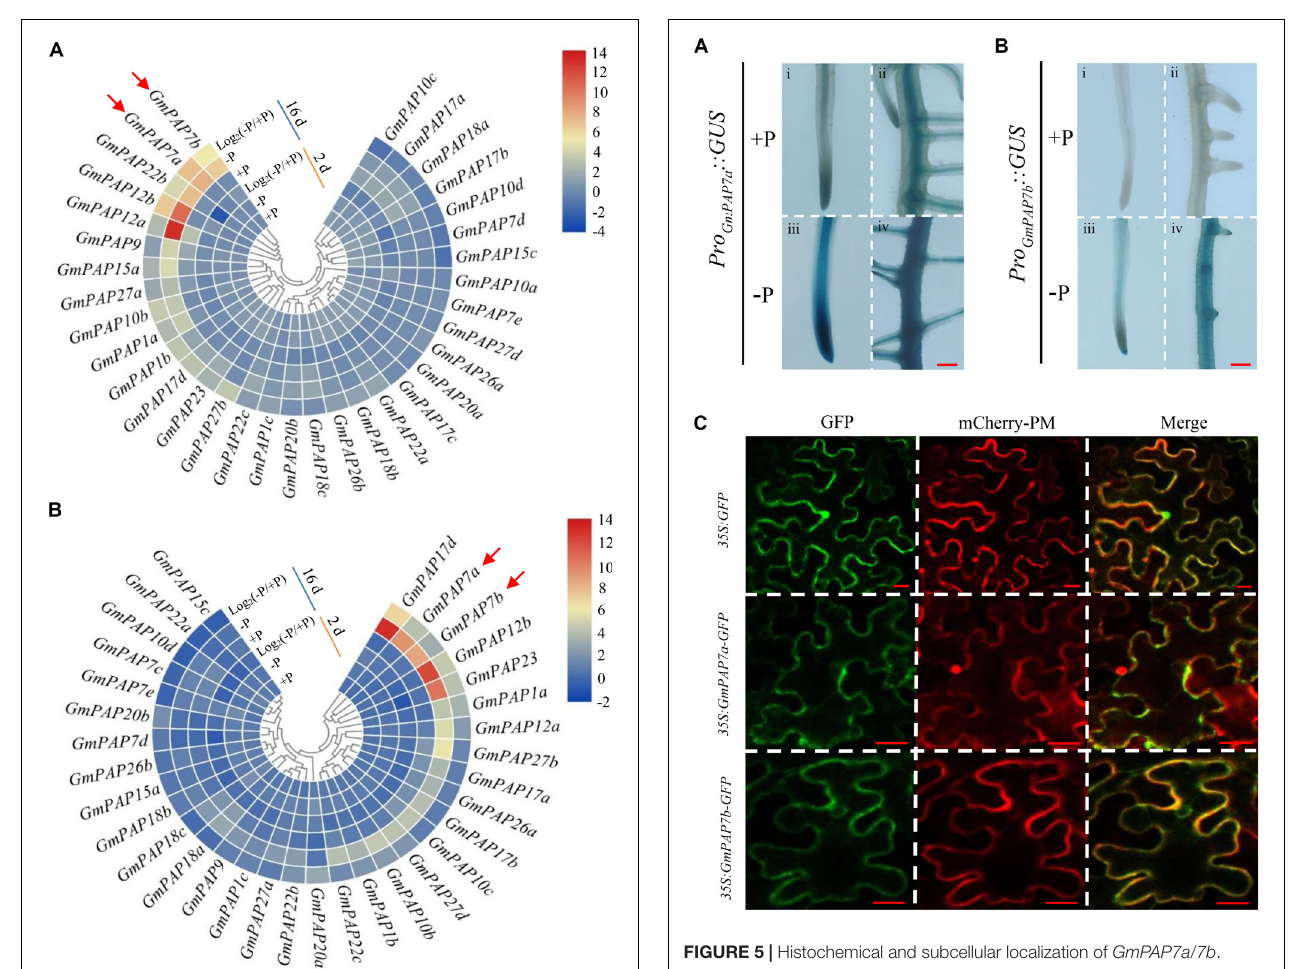
FIGURE 5 | Histochemical and subcellular localization of GmPAP7a / 7b . (A) GUS staining of transgenic soybean hairy roots harboring the GmPAP7a promoter (i–iv). (B) GUS staining of transgenic soybean hairy roots harboring the GmPAP7b promoter (i–iv). Transgenic soybean hairy roots were grown on MS media supplemented with 1250 (+P) µ M or 5 µ M (–P) KH 2 PO 4 for 7 days, and then incubated with GUS staining for further analysis. Bars = 50 µ m. (C) Subcellular localization of GmPAP7a and GmPAP7b. Transient expression of empty vector control ( 35S:GFP ) or 35S:GmPAP7a / 7b-GFP constructs in tobacco leaf epidermal cells. Both GFP and mCherry-PM fluorescence were observed using confocal microscopy. mCherry-PM indicated the plasma membrane AtPIP2A -mCherry marker. Bars = 20 µ